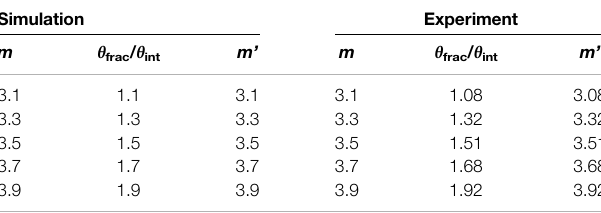
TABLE1| ComparisonoffractionalPGPmeasuredbysimulationandexperiment.